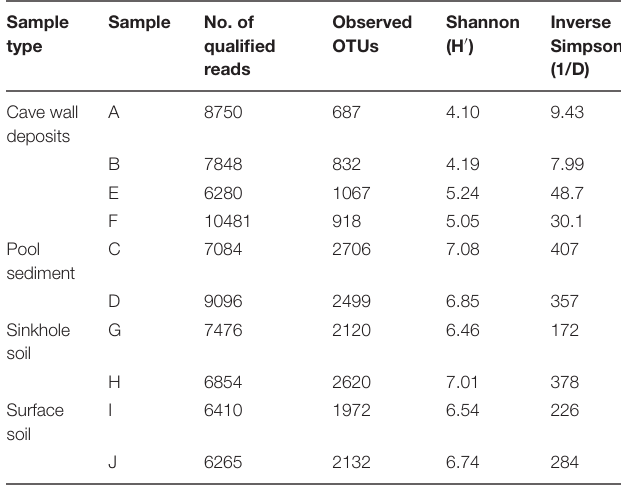
TABLE 2 | Summary of 454 pyrosequencing and calculated diversity indices for each sample a